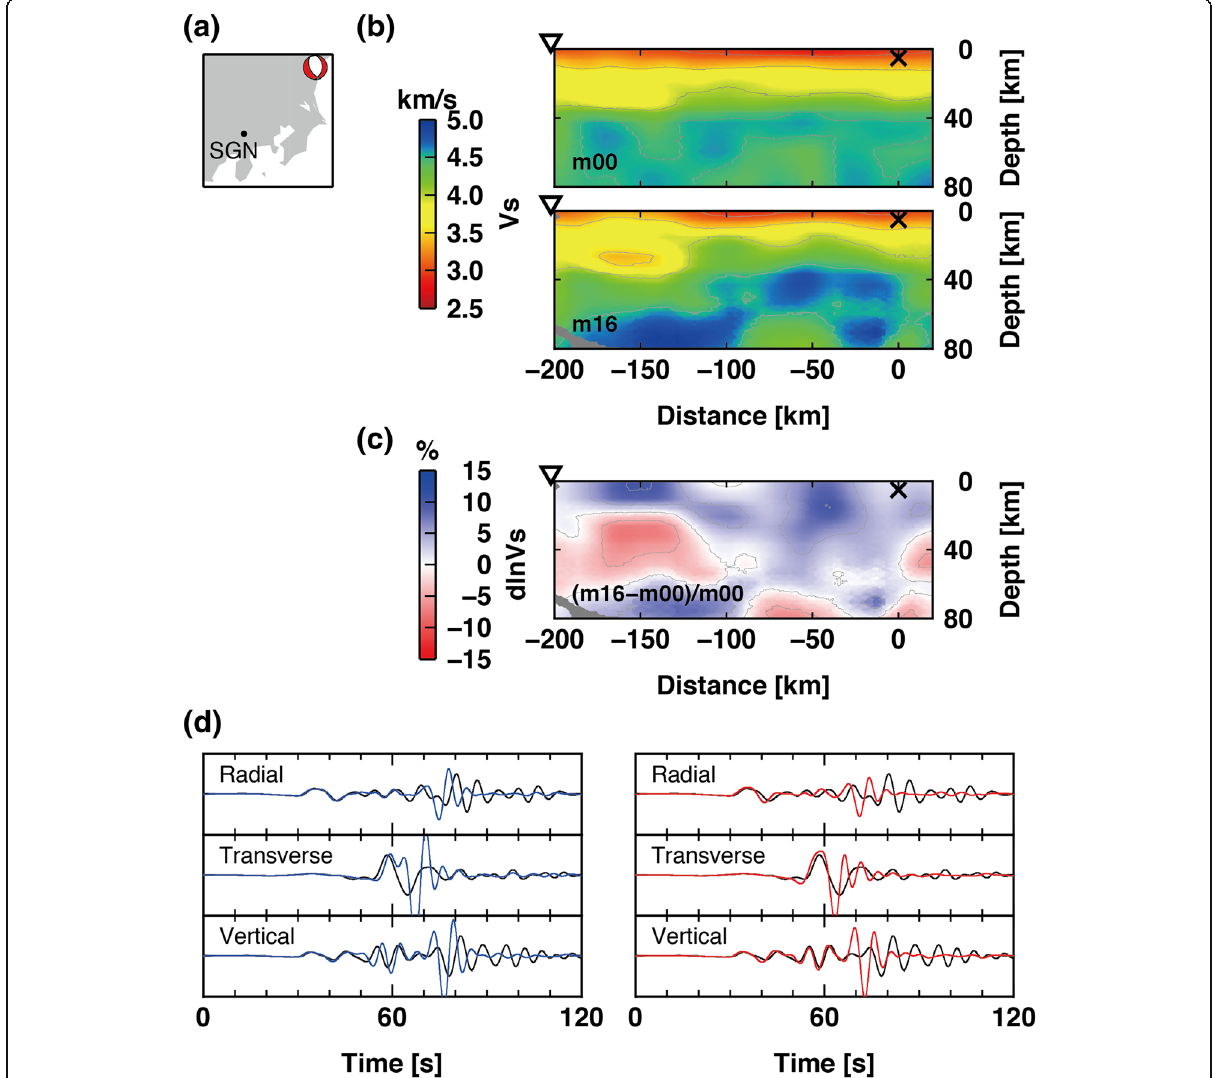
Fig. 14 Same as Fig. 8 for the wave speed models and waveforms for the extra shallow event (Feb. 19, 2012; M W 4.9). a Source and receiver. b Vertical cross section of V s for m 00 and m 16 . c Vertical cross section of the difference between the V s values for m 00 and m 16 . d Waveform comparisons. The gray areas in ( b ) and ( c ) indicate areas of low data coverage. The crosses and inverted triangles in ( b ) and ( c ) show the location of the earthquake and station in ( a ), respectively. The black, blue, and red lines in ( d ) indicate the observed, m 00 , and m 16 waveforms,